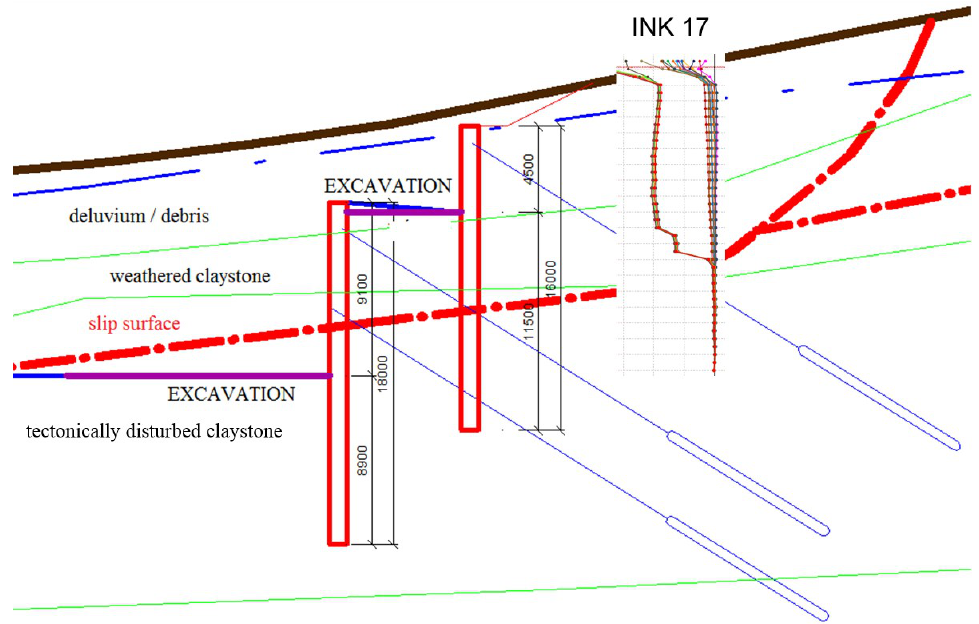
Figure 3. Geotechnical model at km